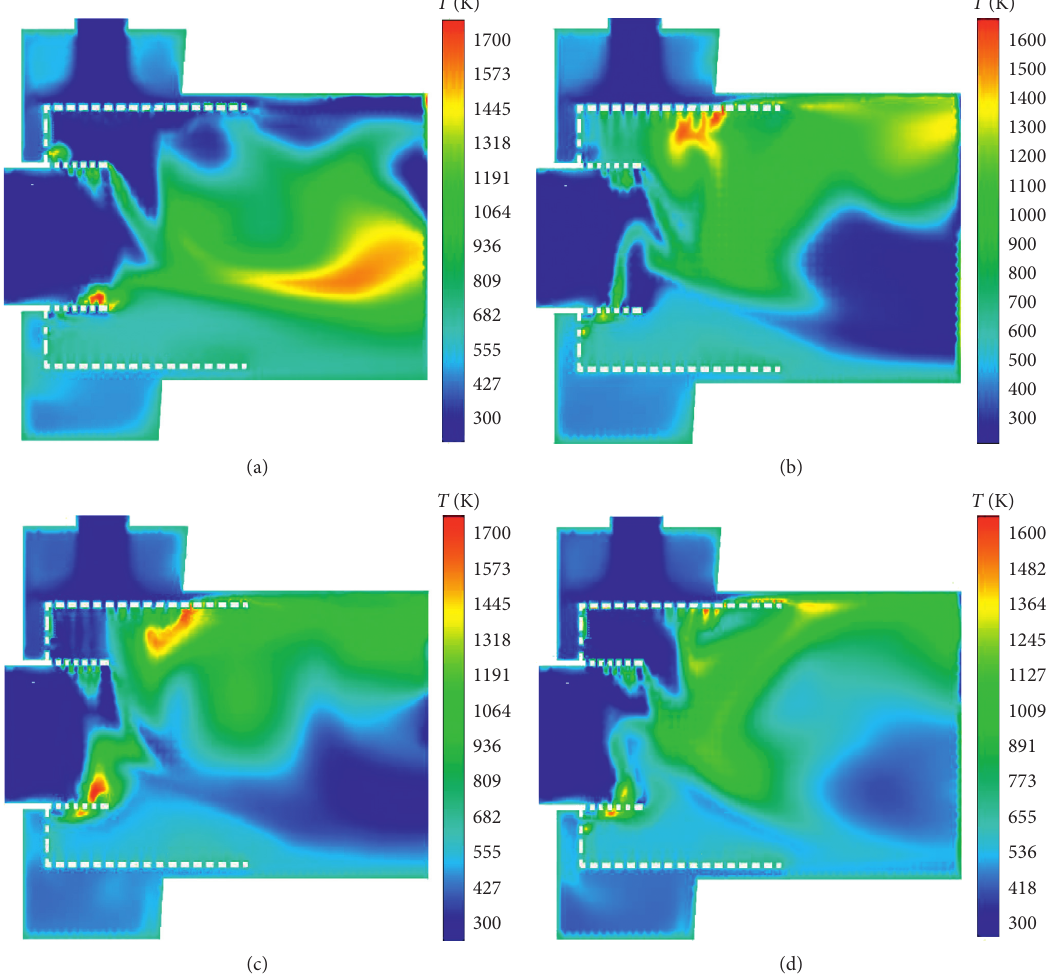
Figure 6: Longitudinal distribution of the combustion temperature of the rotary burner under different excess air coefficients. (a) α � 1.0. (b) α � 1.4. (c) α � 1.8. (d) α � 2.2.